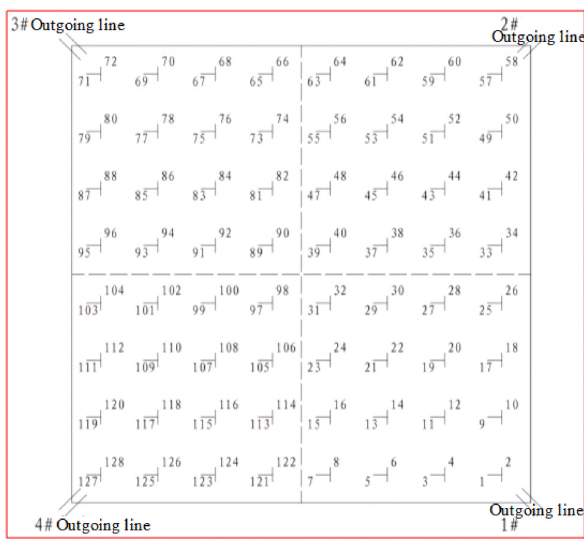
Fig. 4 Layout of the strain measuring points in the model